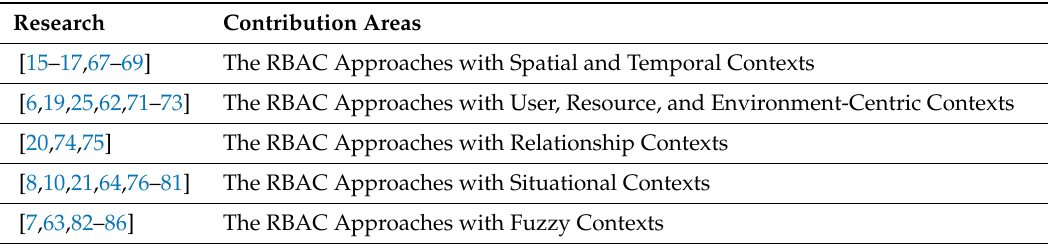
Table 4. The access control research and contribution areas in the centralized